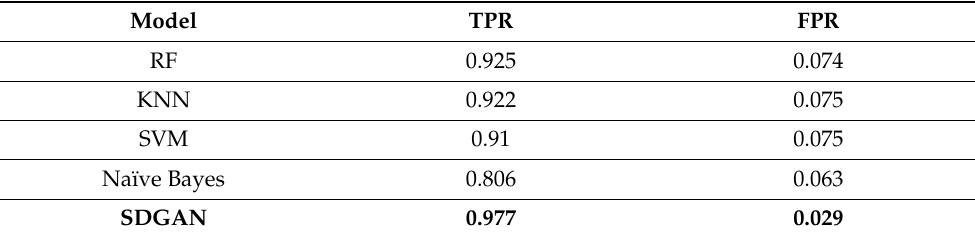
Table 5. ML-based defense DDoS detection and SDGAN on conventional